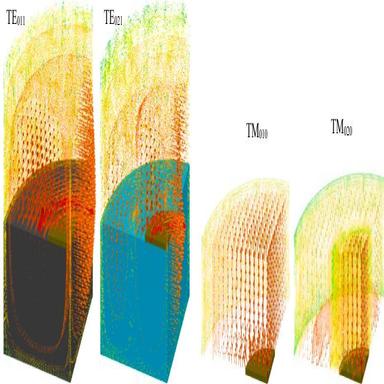
E-field distributions in resonator R11 (modes TE011 and TE021) and resonator R21 (modes TM010 and TM020), in which the sample diameter is smaller than the resonator diameter (30 mm).